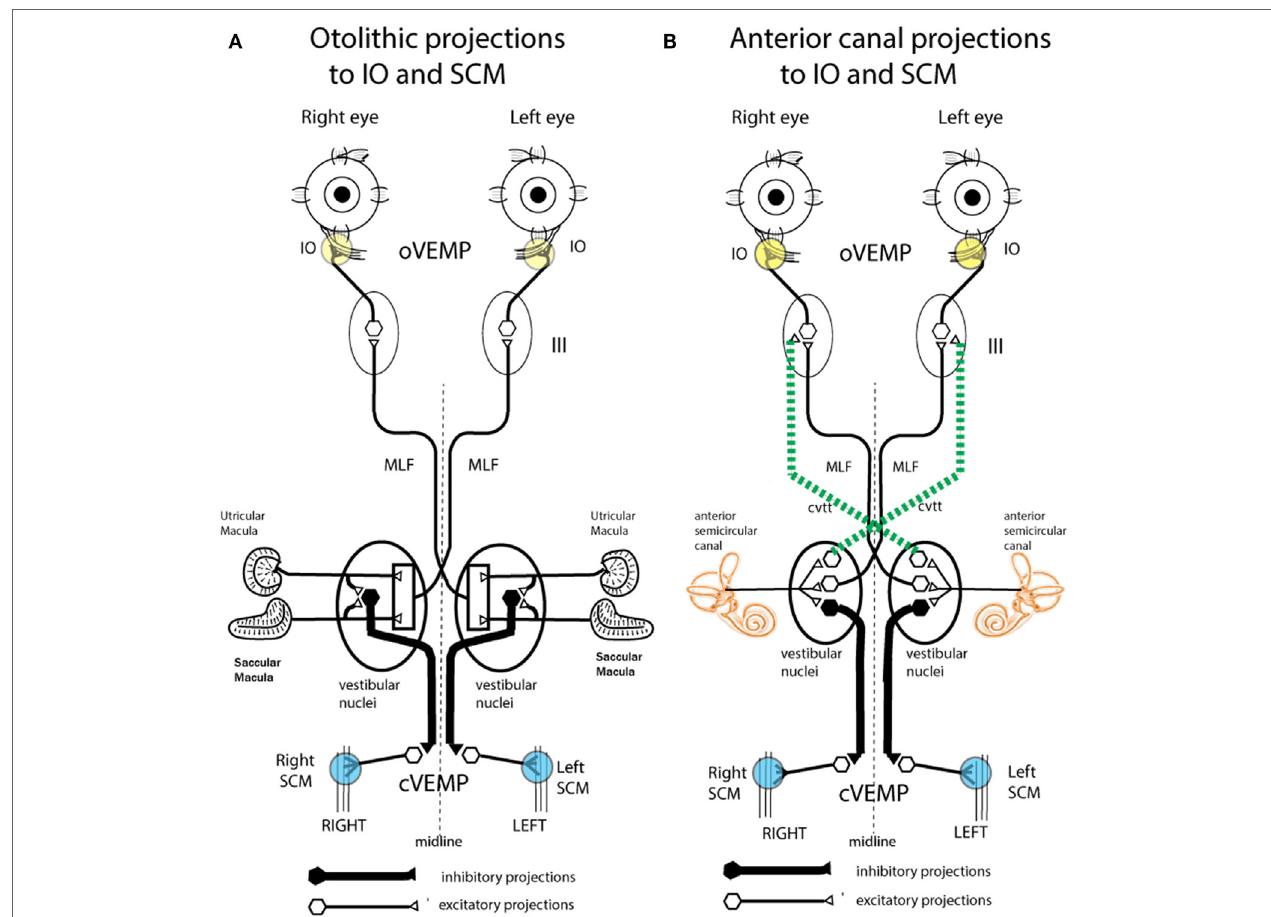
FigURe 8 | Schematic representations of the major neural projections from vestibular receptors to the eye muscles and the neck muscles. (A) The otolithic projections to inferior oblique eye muscle (IO) and sternocleidomastoid muscle (SCM). (B) The analogous projections of the anterior semicircular canal neurons to the IO and SCM (72). Stimulation in animals with intact labyrinths causes the neural connections shown on the left panel to be activated. However, after a semicircular canal dehiscence (SCD), the anterior semicircular canals are also activated by sound and vibration, so the neural projections on the right come into play. The green dotted lines represent the projection from the anterior canal neurons in the vestibular nucleus to the contralateral third nerve nucleus via the crossed ventral-tegmental track. It appears that it is this combination of otolithic and canal afferent activation which in part results in the enhanced ocular vestibular-evoked myogenic potential (oVEMP) and cervical vestibular-evoked myogenic potential (cVEMP) responses after SCD. (A) Reprinted by permission from John Wiley and Sons, Curthoys et al. (80), © 2011. (B) Reprinted by permission from Springer Nature, Curthoys (81), ©